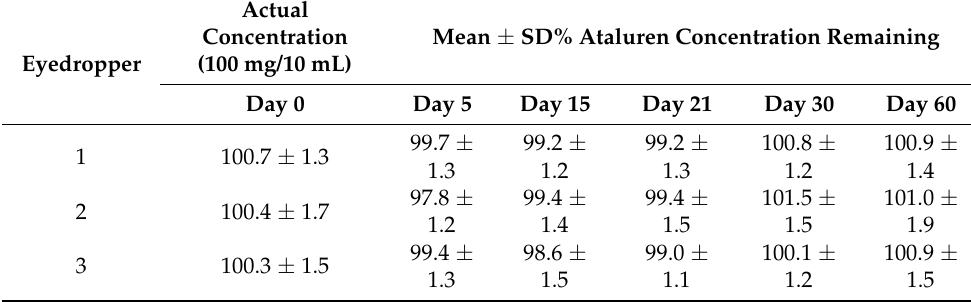
Table 6. Chemical stability of ataluren 1% eye drop castor oil and dimethylsulfoxide